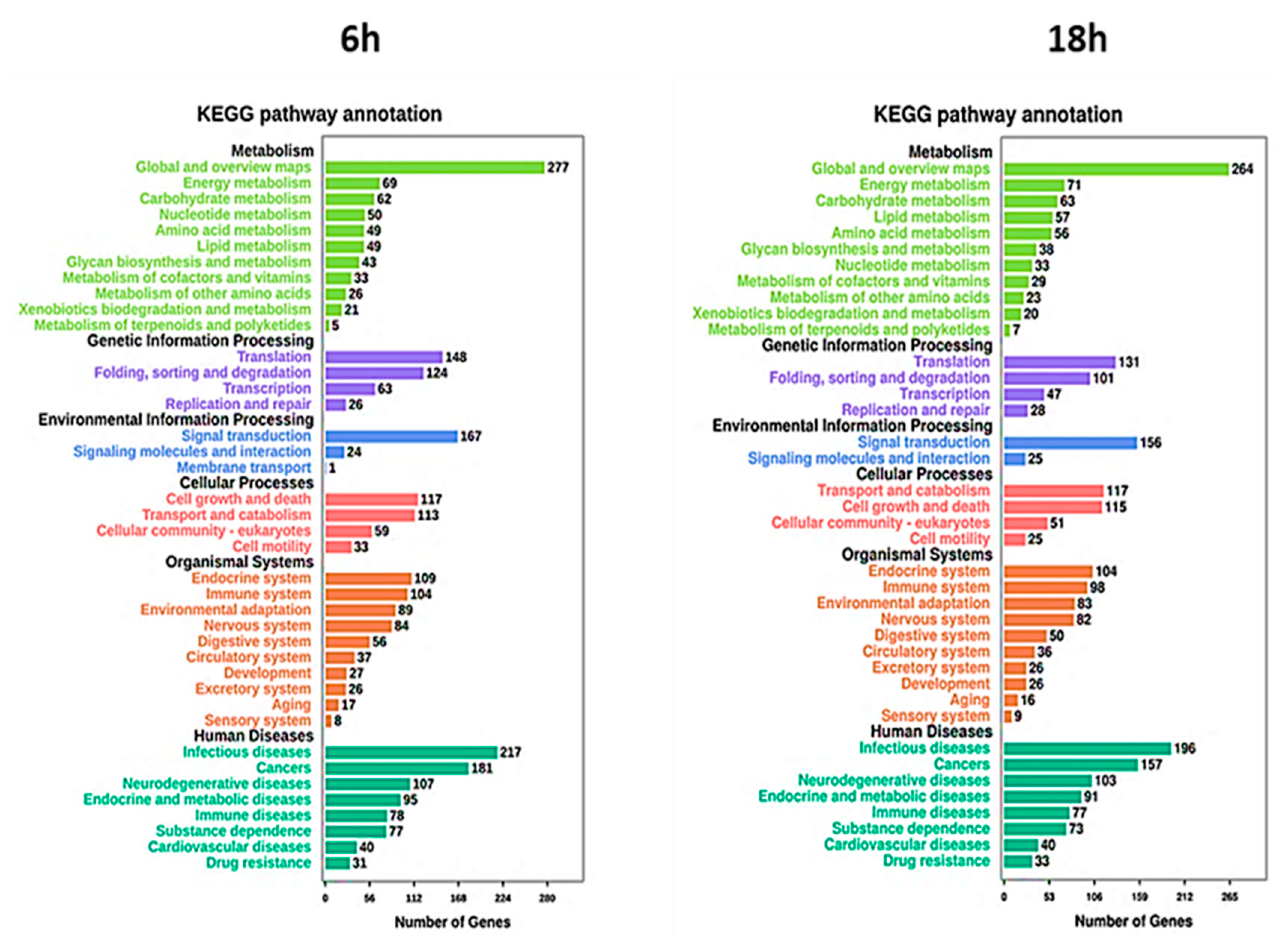
Figure 8. KEGG analysis. The pathways involved in the DEGs were analyzed using KEGG analysis. The number of enriched genes and pathway terms are presented.